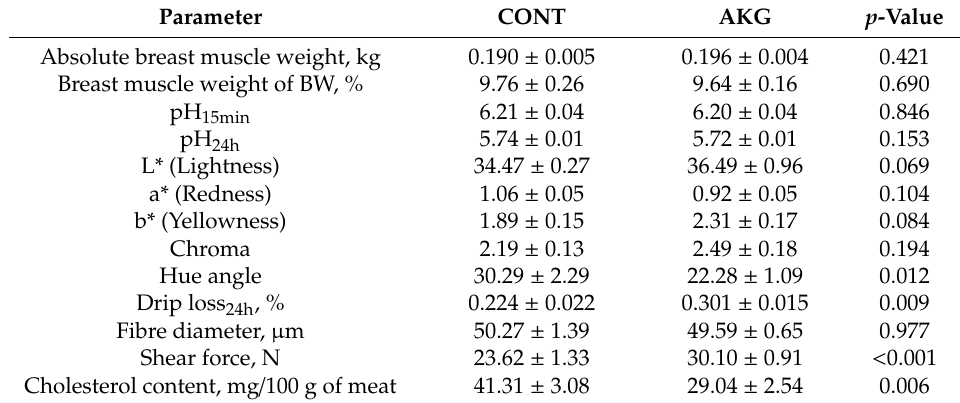
Table 4. The influence of AKG supplementation during the experimental period (31–60 weeks of age) on the breast muscle microstructure, physical properties and breast muscle cholesterol content in laying hens at the age of 60 weeks.